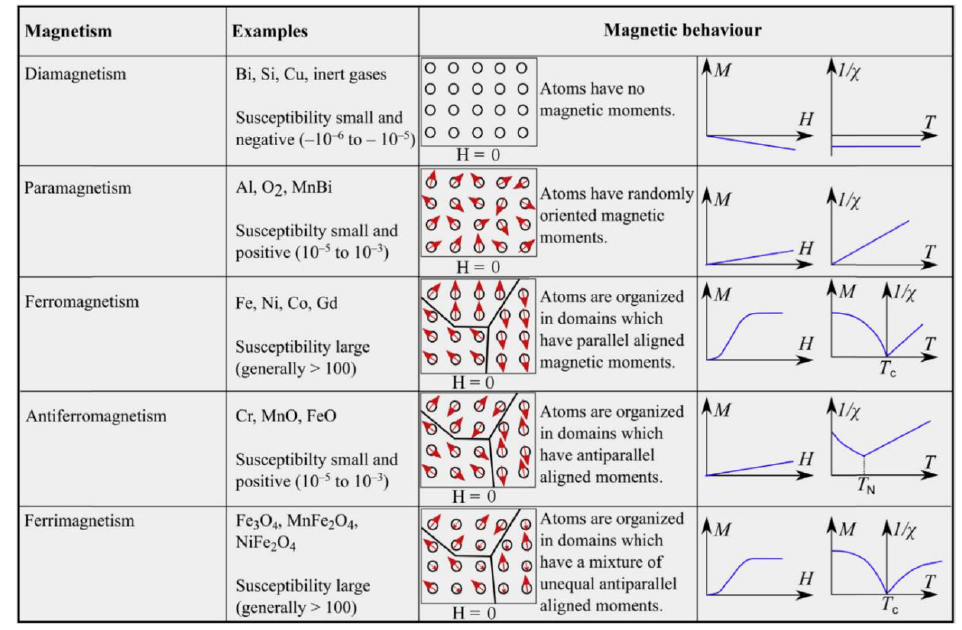
Figure 7. Summary of the main relevant forms of magnetism and their features. Reprinted with permission from [57], published by Woodhead Publishing and Elsevier, 2016.